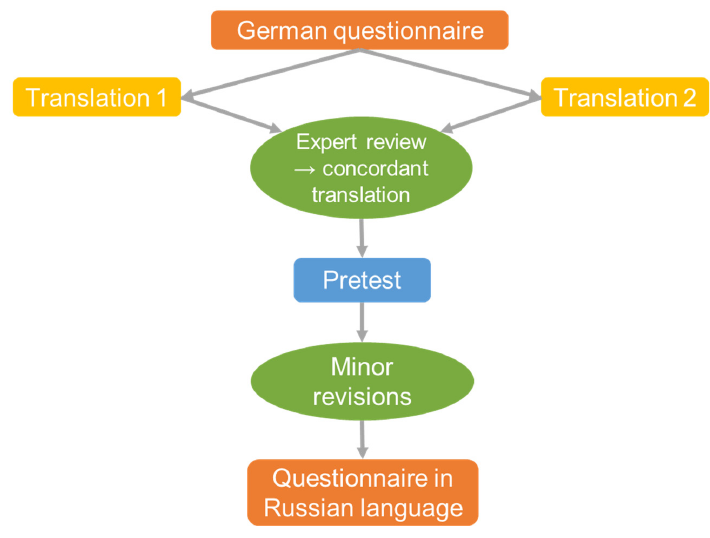
Figure 2. HLS 19- Q adaptation process in Germany. Figure 2. HLS 19 -Q adaptation process in